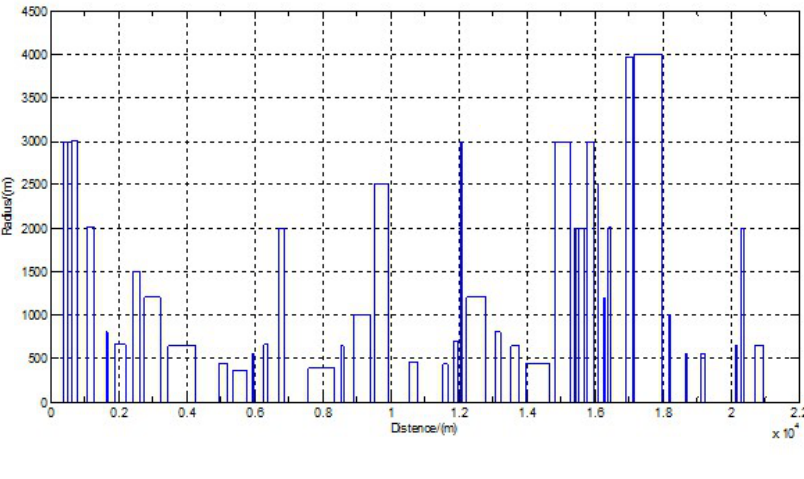
Figure 9. Curvature radius data. Table 6. Speed limit data.